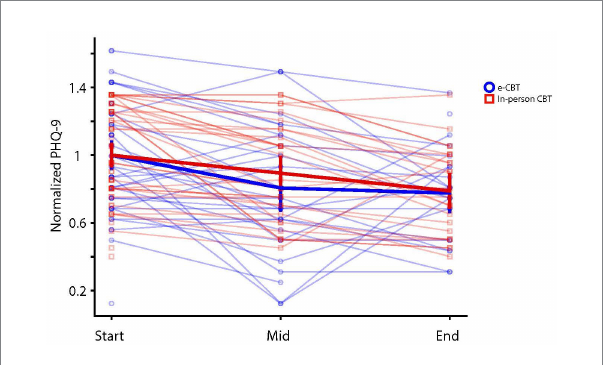
FIGURE 5 Individual and average (± 2SE) normalized PHQ-9 scores across e-CBT and in-person CBT groups over the three time